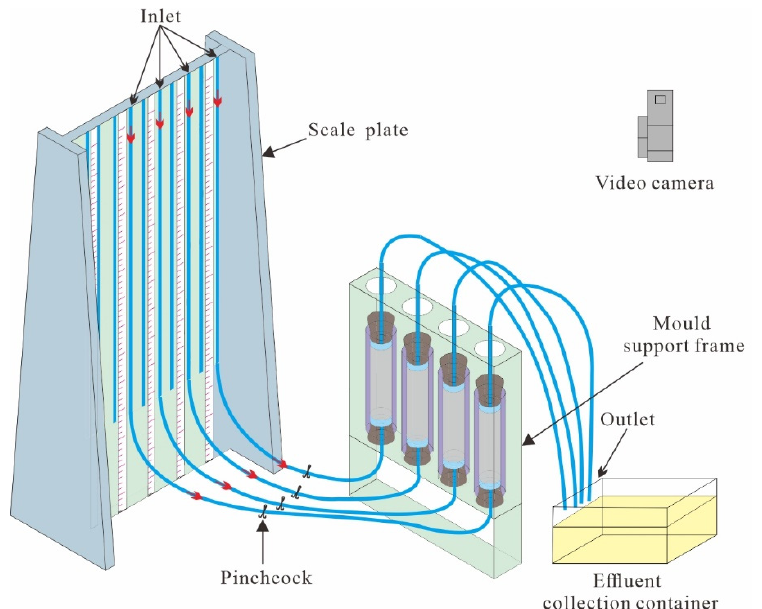
Figure 5. Experimental set-up for induced mineralization and permeability tests. Two mold support frames of the same size (length × width × height = 42 cm × 8 cm × 53 cm) were used to place eight sand molds for tests. The HD camera was placed in a fixed